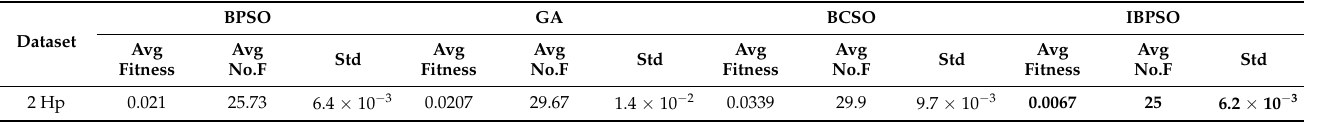
Table 9. Comparison between IBPSO based on fitness value and number of selected features in this case study. Dataset